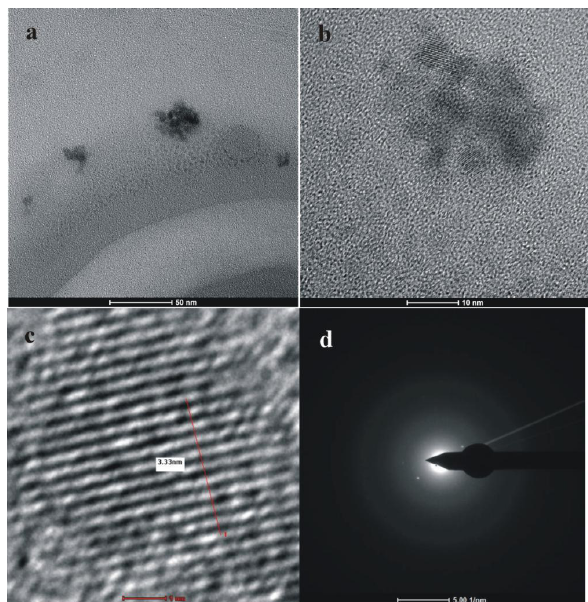
Figure 2. Panel (a) shows the TEM image, (b) , (c) high-resolution (HRTEM) images, and (d) selected area electron diffraction (SAED) pattern of an S-, O-, Hg-containing particle aggregation obtained from an ascending gas flow above the soil over the Dong- shengmiao deposit.